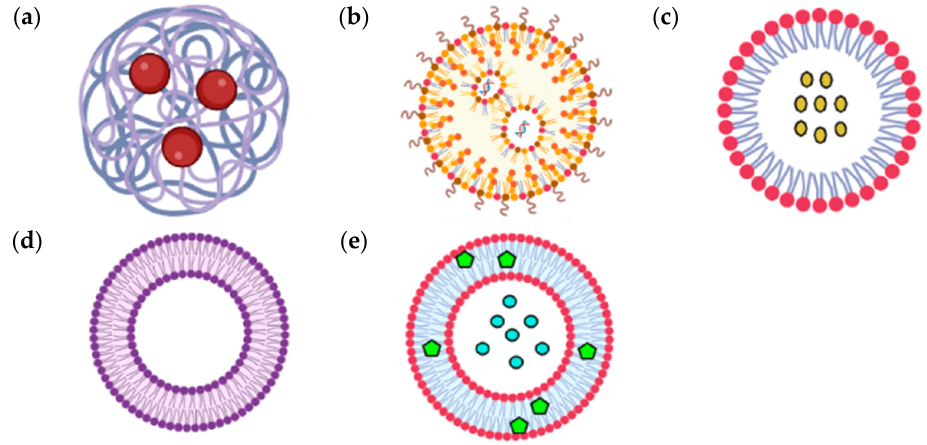
Figure 4. Schematic representation of various nano-particulate systems investigated with A. paniculata and andrographolide. ( a ) Polymeric nanoparticles, ( b ) solid lipid nanoparticles, ( c ) polymeric micelles, ( d ) liposomes, and ( e ) niosomes (created using BioRender.com, accessed on 1 September 2022). Table 1. Types of nanoparticle formulations and their pharmacological and pharmaceutics studies, with their biological activity.